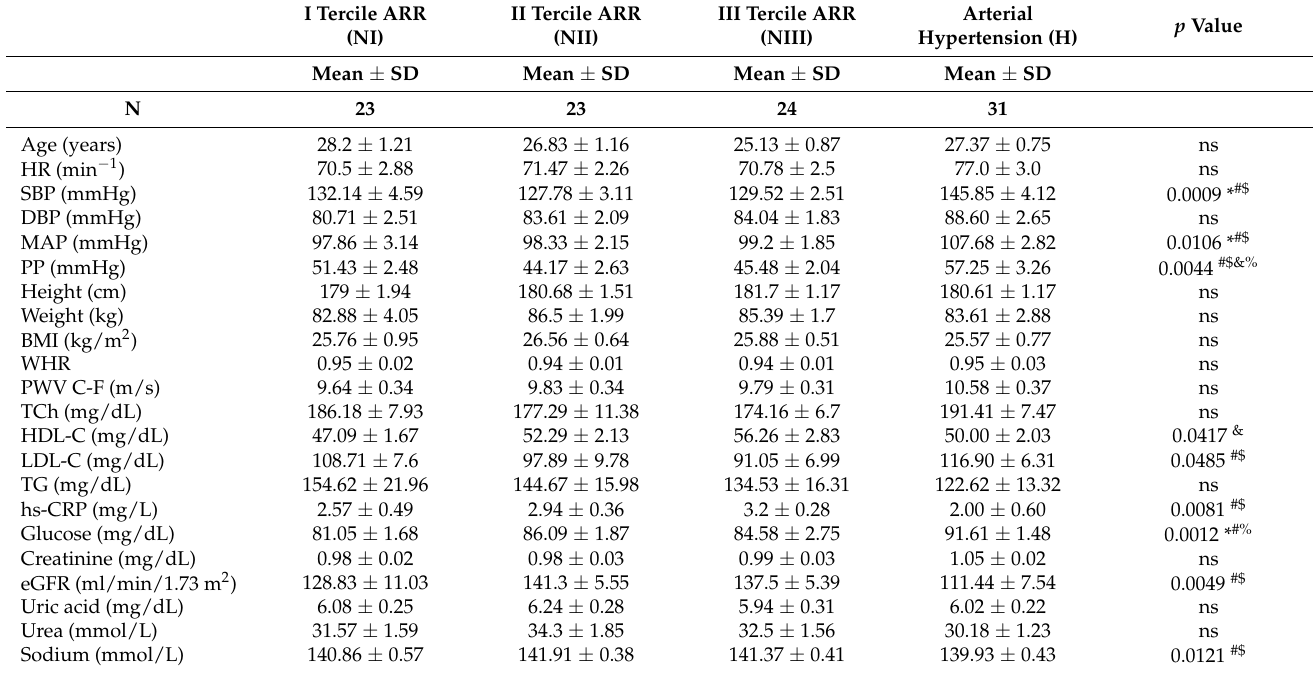
Table 1. Baseline demographic characteristics and biochemical cardiovascular risk